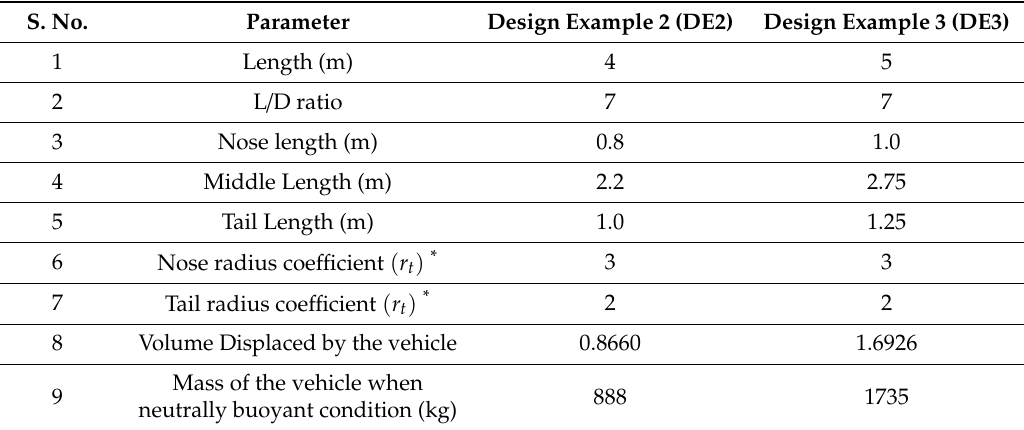
Table 7. Detail design parameters of AUV with integrated buoyancy